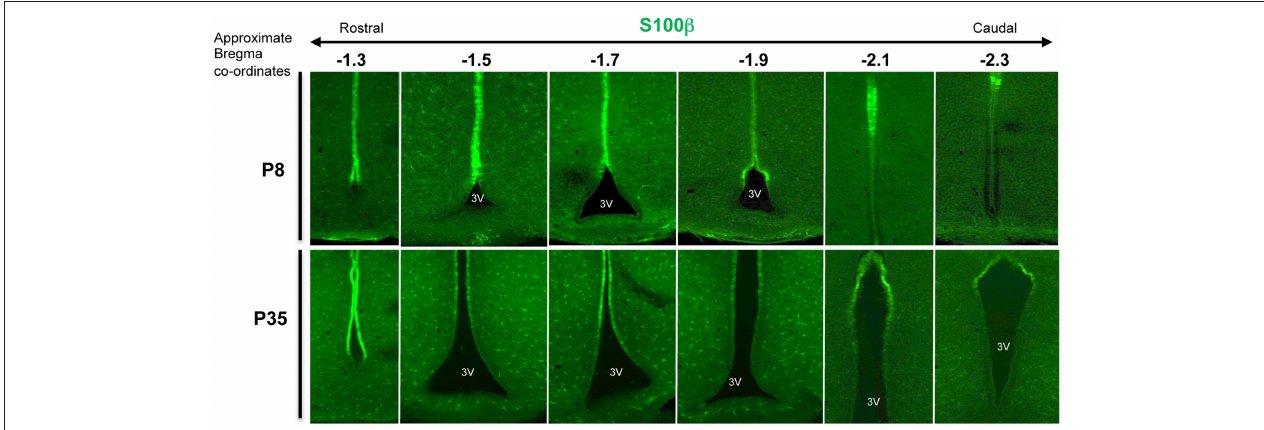
FIGURE 2 | Varying dorso-ventral S100 β expression in the 3V ependymal lining. Coronal section of mouse hypothalamus at postnatal days 8 (P8) and P35, immunolabeled with anti-calcium binding protein, S100 β antibodies, which largely encompasses the domain of α -tanycytes and ependymal cells. Note the varying dorso-ventral extent of this marker at different bregma levels (here from –1.3 to –2.3), and the additional punctate expression by glial cells/glial progenitors within the neighboring